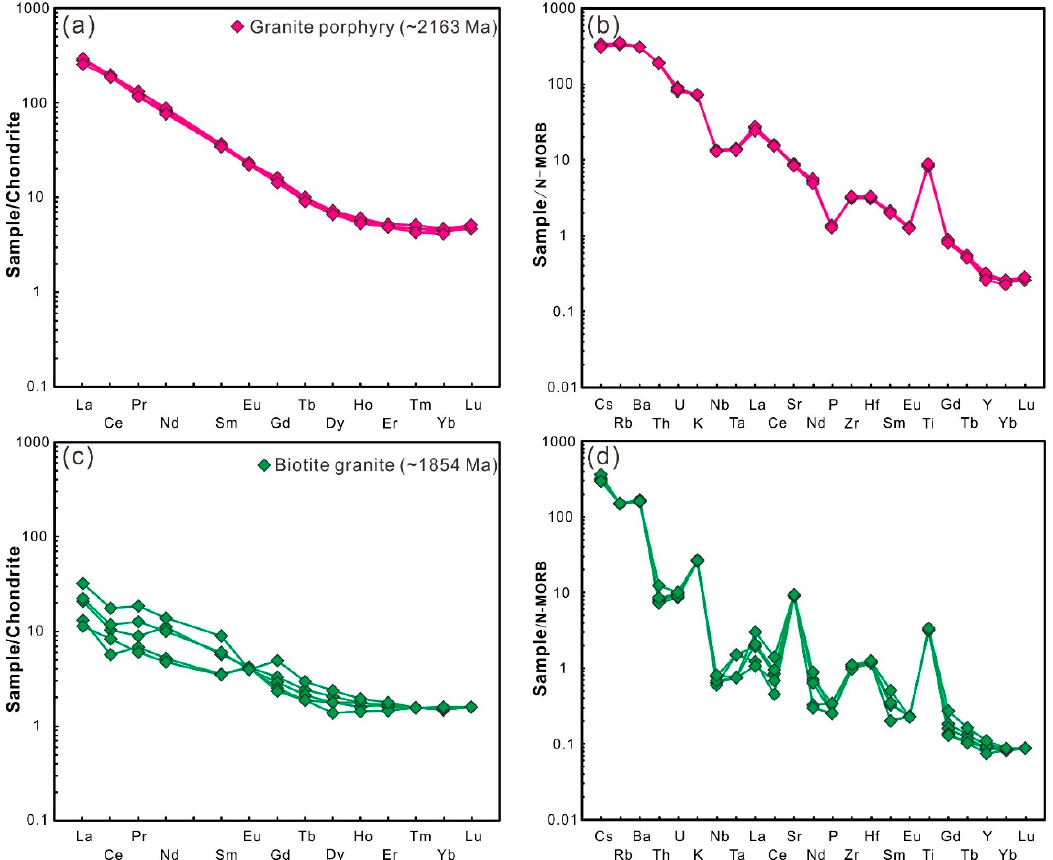
Figure 7. Trace element geochemical diagram of Paleoproterozoic igneous rocks in Qingchengzi district (Note: the normalized values of chondrite and N-MORB are from Sun and McDonough [56]). ( a , c ) Chondrite-normalized rare earth element patterns, ( b , d ) N-MORB normalized trace element patterns.